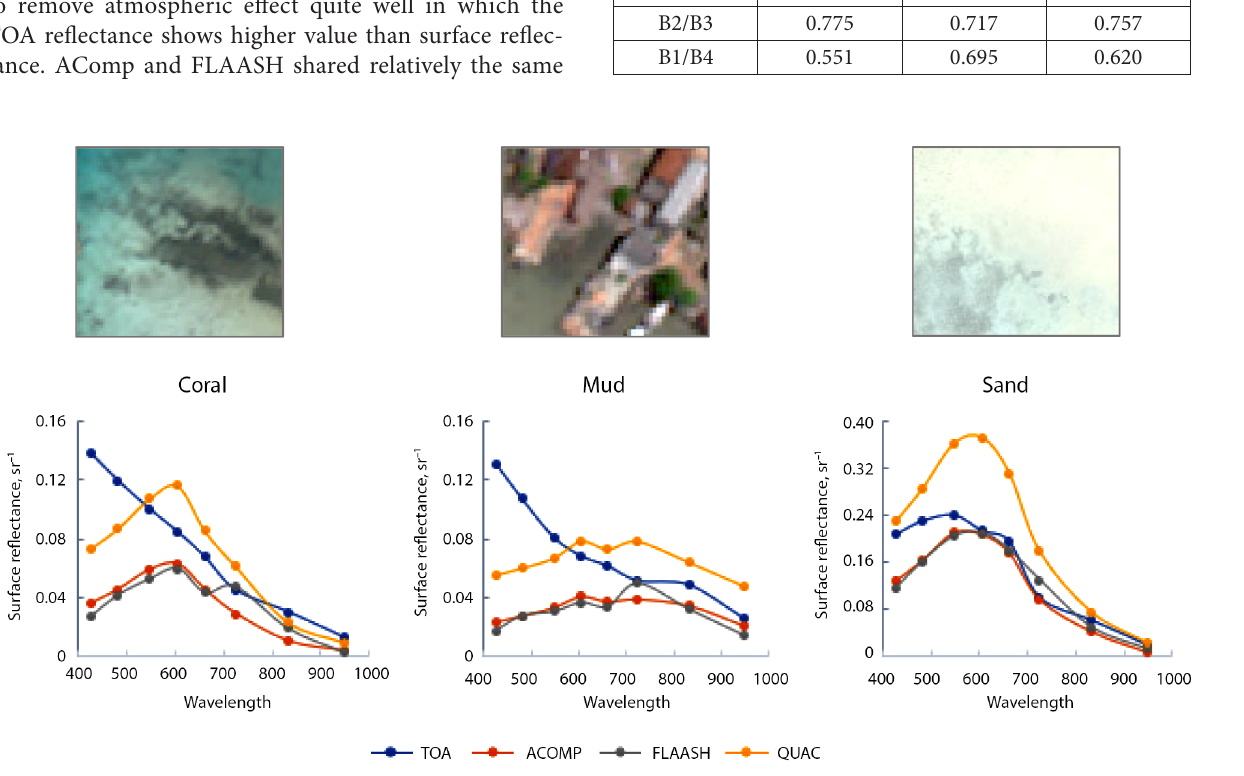
Figure 4. Comparison of TOA reflectance and surface reflectance obtained from three atmospheric correction models (AComp, FLAASH and